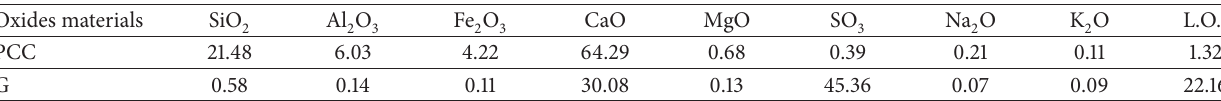
Table 2: The chemical composition of the raw materials, mass